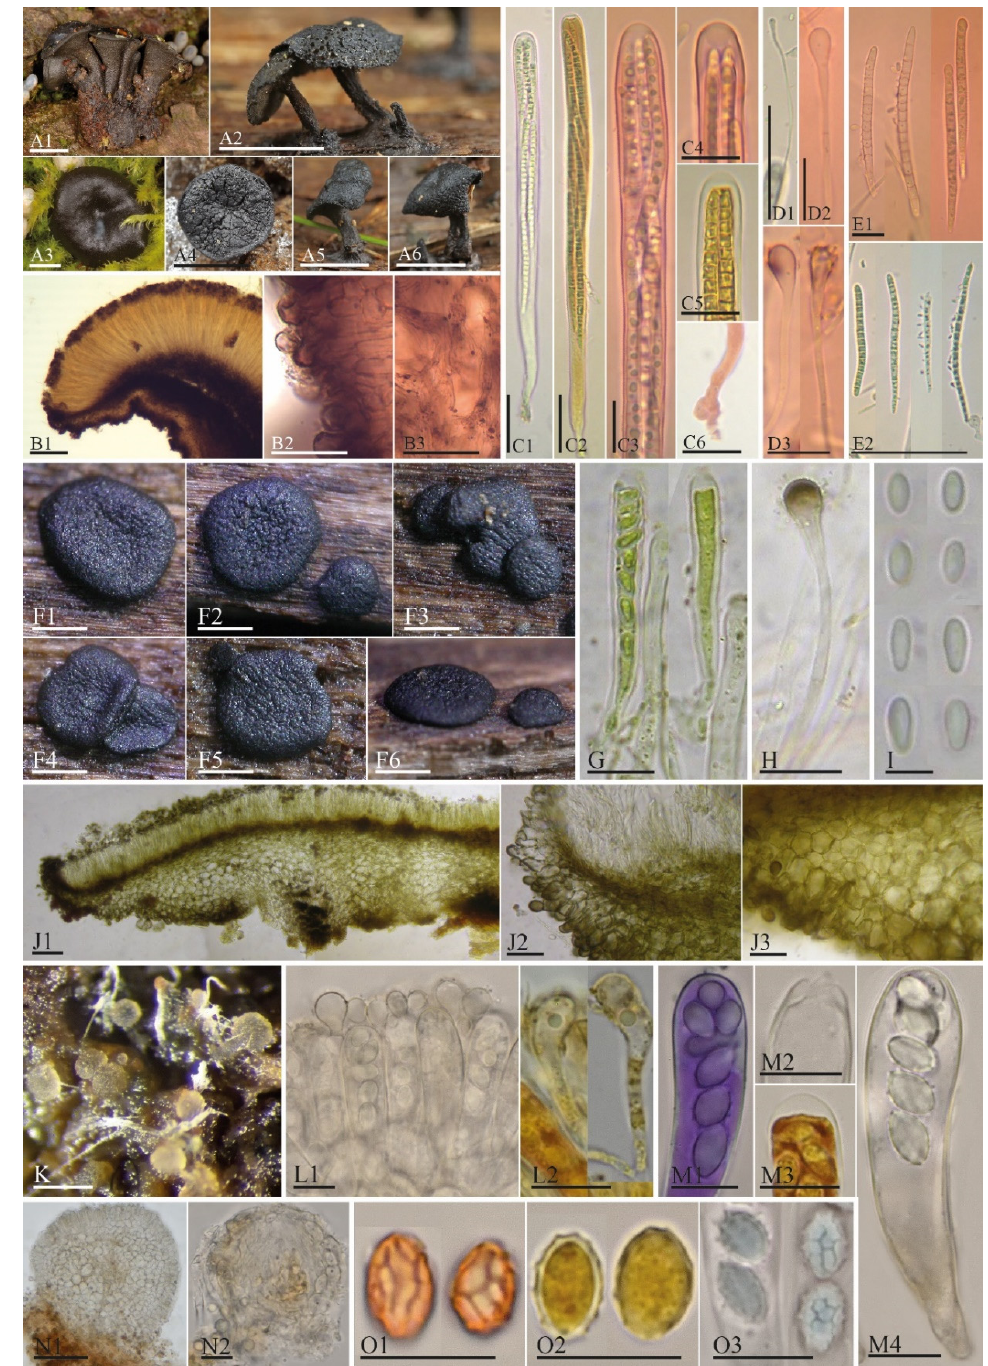
Figure 6. Phenotypic features of Holwayaceae : Holwaya ( A1 – 6 , B1 – 3 , C1 – 6 , D1 – 3 , E1 – 2 ), Patinella ( F1 – 6 , G , H ,I,J 1 – 3 ) [84], and Ramgea ( K , L1 – 2 , M1 – 4 , N1 – 2 , O1 – 3 ) [64]. Comparative morphological features among genera in the family: A, F, and K. Macromorphology of the apothecia: B, J, and N. Excipulum in transverse section: C, G, and M. Asci and details of ascus apex: D, H, and L. Paraphyses: E, I, and O. Ascospores. A1, A3 from CNF 2/8749; A2, A4–6 from L.Q.H.-102; B1–3, C3–4, D2–E2 from CUP-60122; C1–2, C6, D1 from CUP-A-019509; C5 from CUP-D-02006. A1, A3 phot. N. Matoˇcec, N1 = 100 µ m; B3, C1–2, D1, E2, J1 = 50 µ m; J2 = 20 µ m; B2, C3–6, D2–3, E1, G, H, J3, L1–2, M1–4,